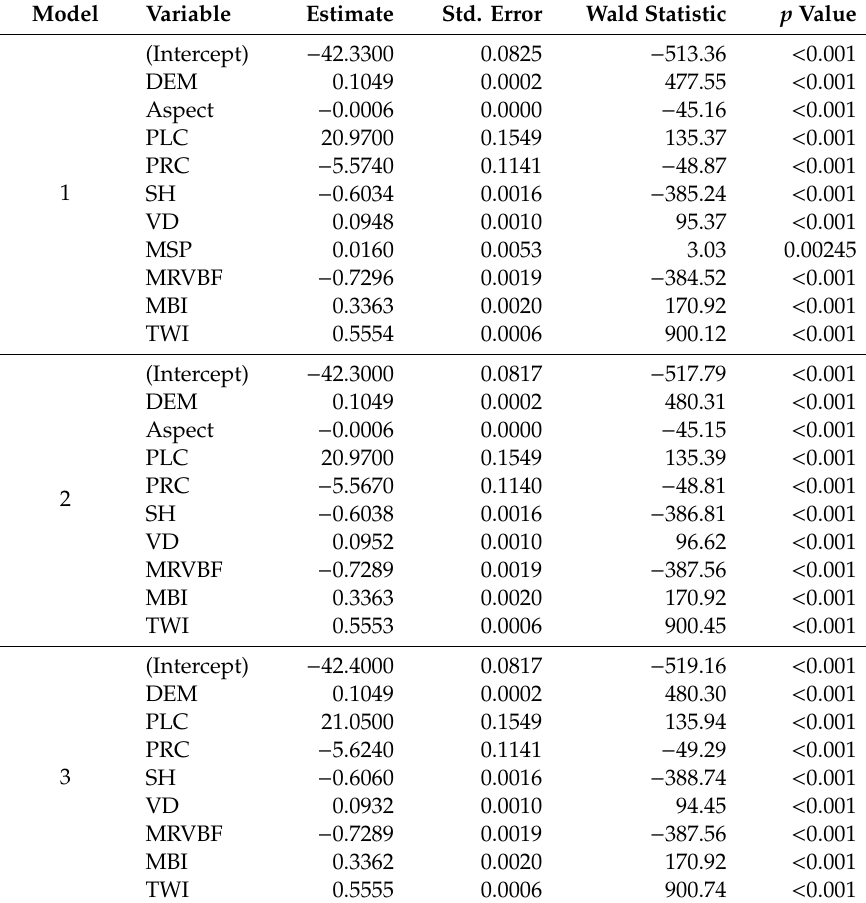
Table 1. Coe ffi cients of the logistic regression for sinkhole prediction models.